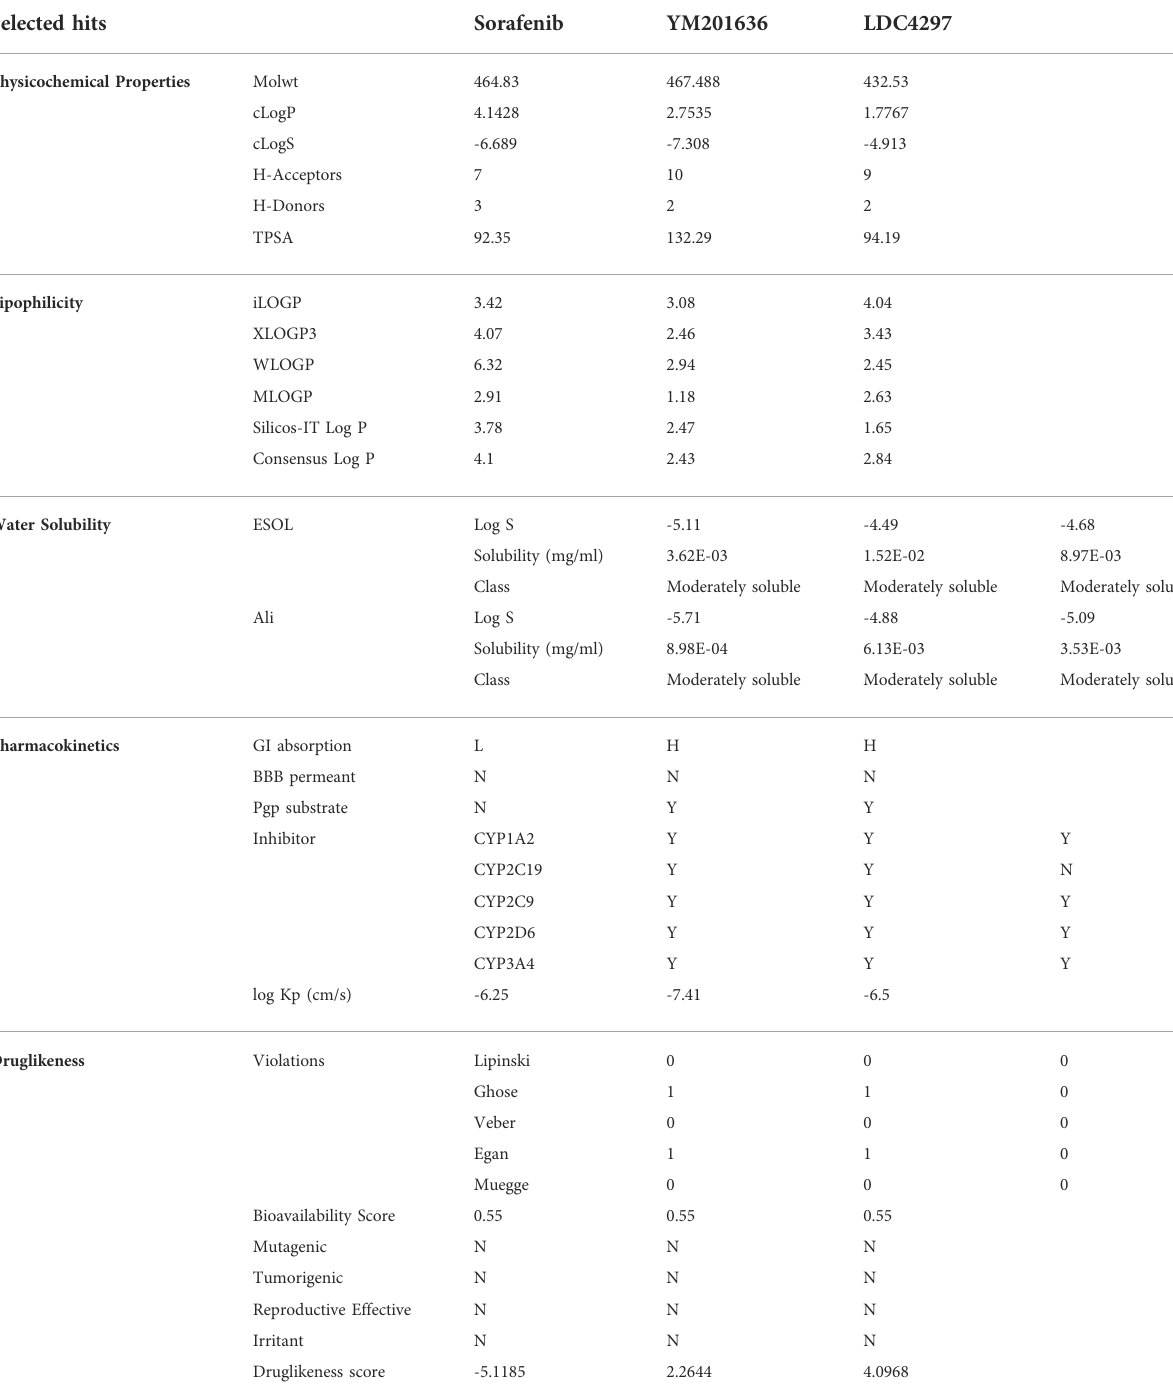
TABLE 3 Physicochemical and druglikeness properties of selected hits. Selected